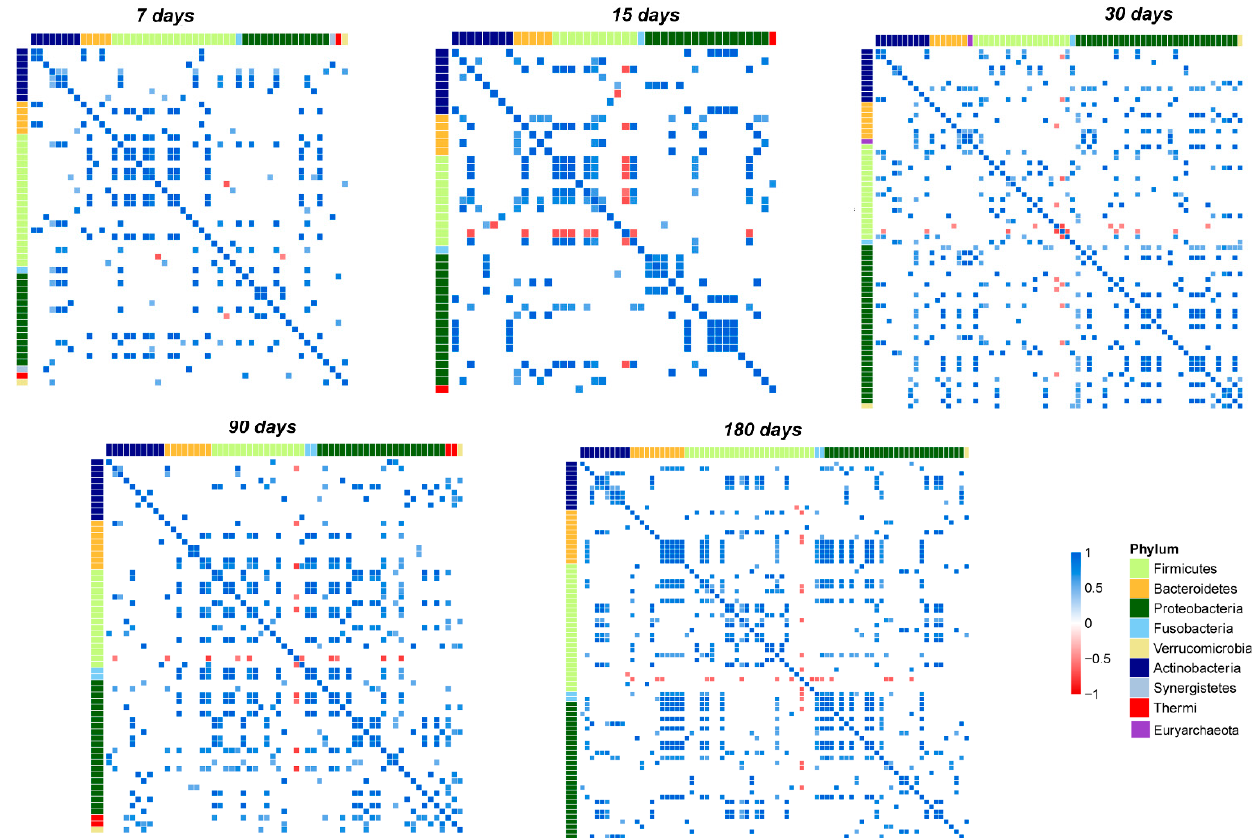
Figure 5. Pearson’s correlation heatmaps of salivary OTUs. Panels that are labeled as 7, 15, 30, 90, and 180 days show the correlation (colored squares) heatmaps between the OTUs. Pearson’s correlations with p FDR < 0.05 are shown. The color scale represents the correlation level: red, negative correlation values; blue, positive correlation values. The OTUs are colored according to the phylum level taxonomy.